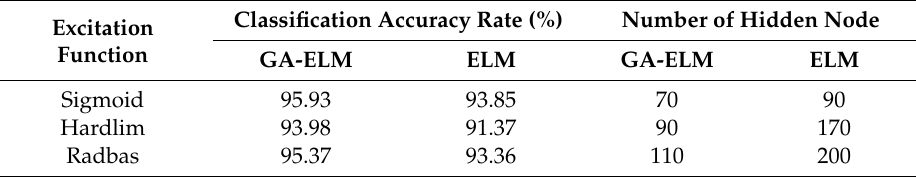
Table 1. Classification accuracy of GA-ELM and ELM under di ff erent excitation functions.